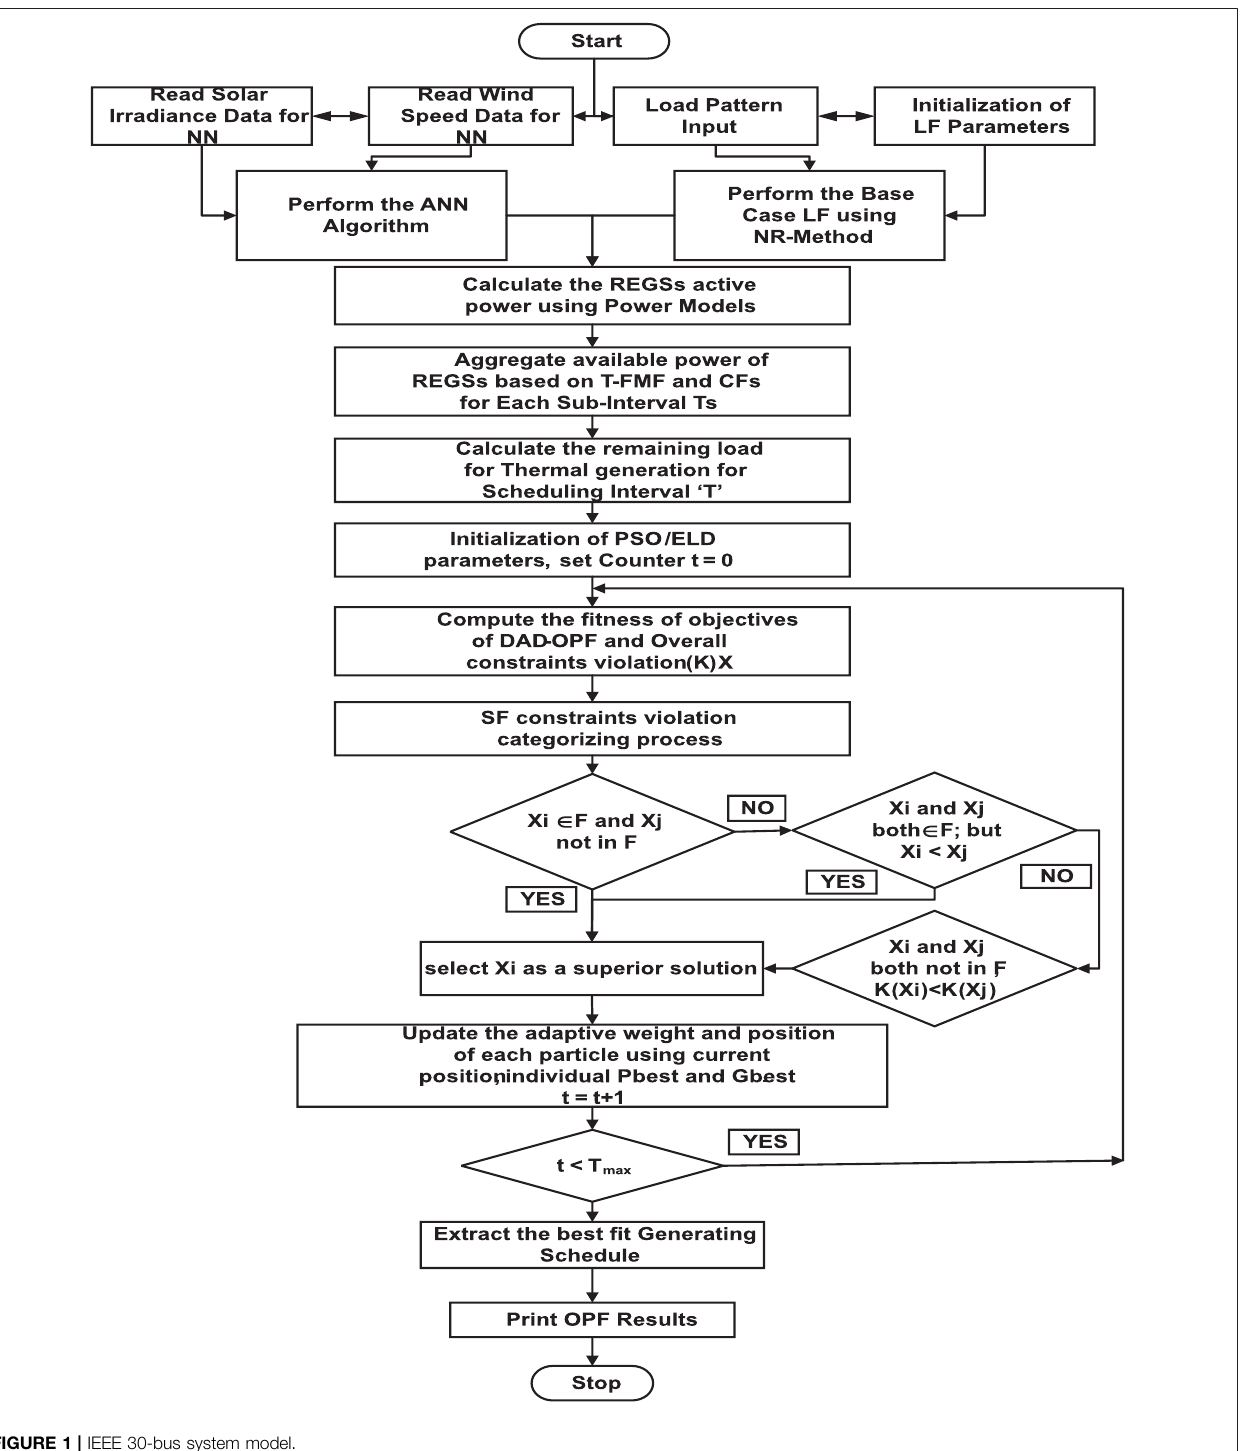
FIGURE 1 | IEEE 30-bus system model.